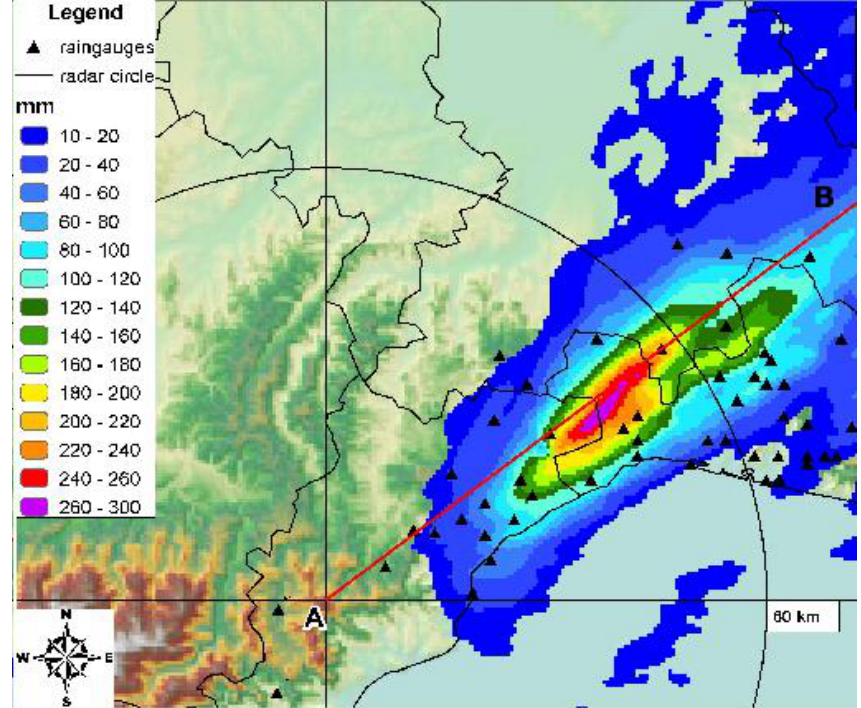
Figure 3. Rainfall accumulation since 00:00 UTC to 09:00 UTC on 16 August 2006 by radar and ground station location estimated by K DP